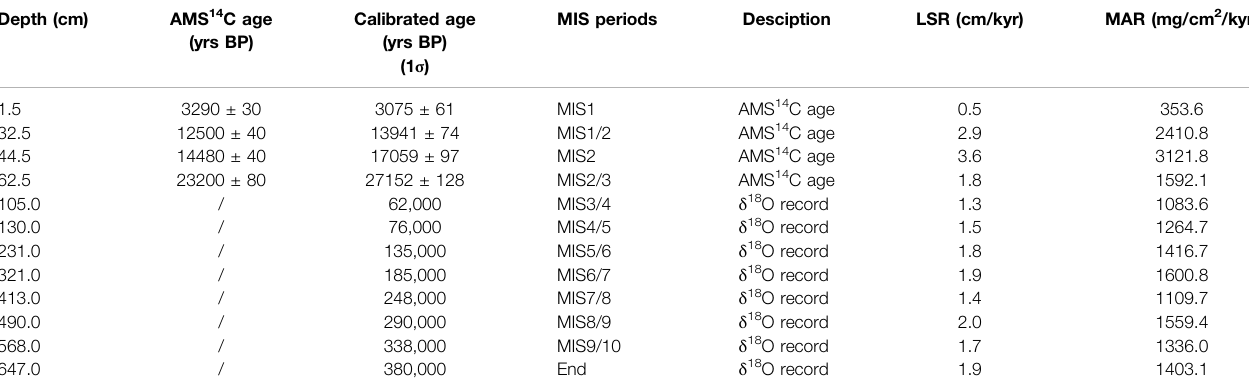
TABLE 1 | Radiocarbon ages with calibrated ages of core St10-PC and control points to construct the age model. Depth